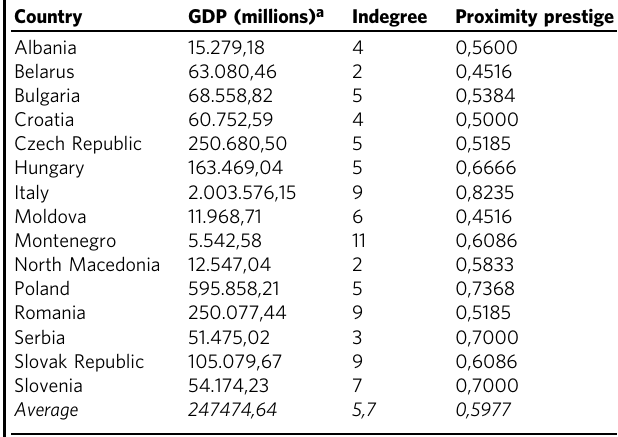
Table 2 Indegree, proximity prestige and GDP of CEI MS: priorities for future